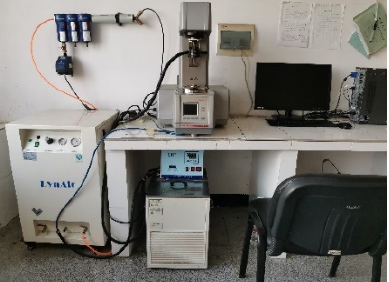
Figure 2. Anton Paar MCR 102 rheometer.